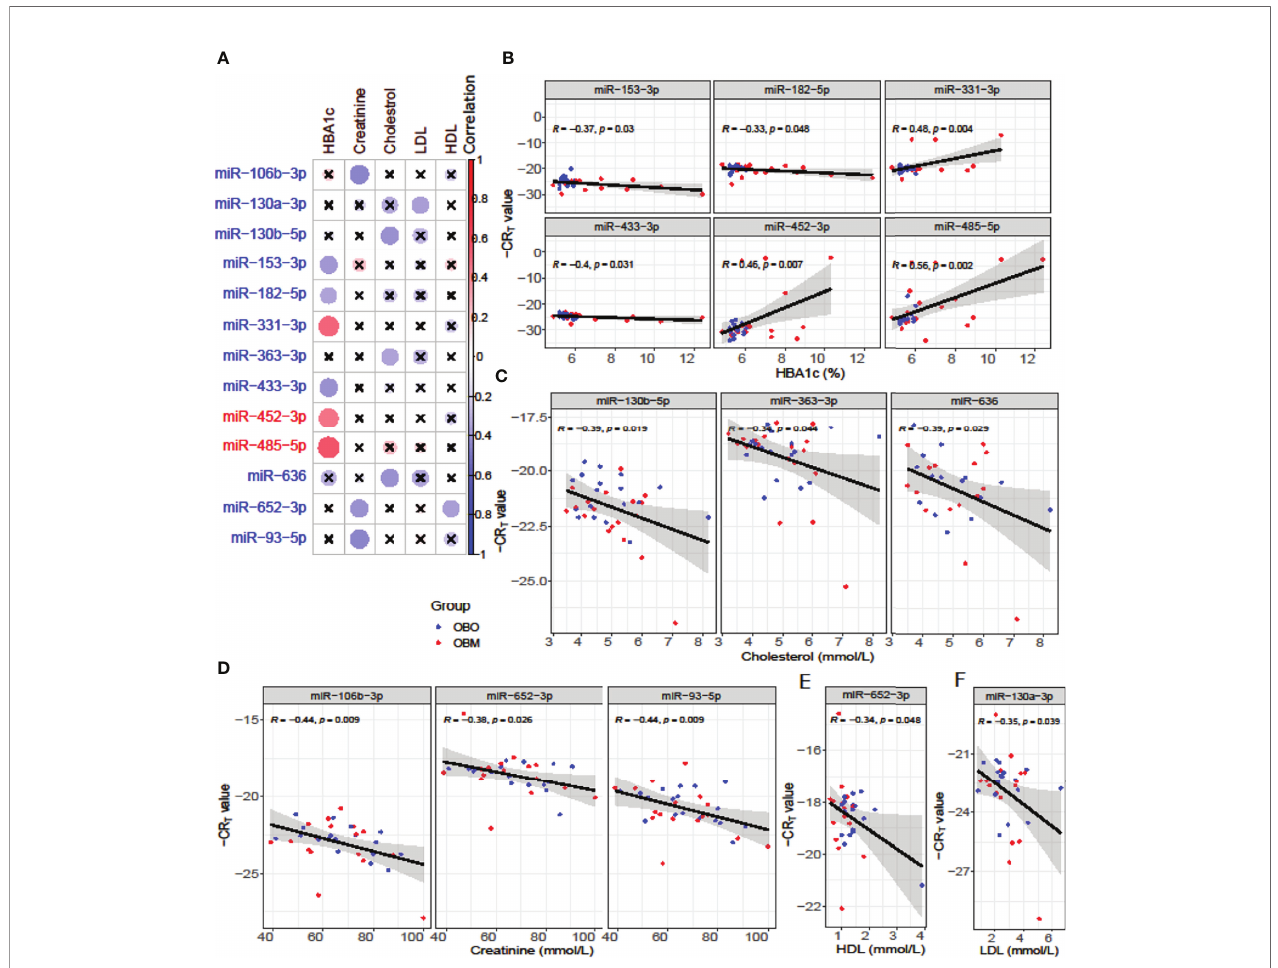
FIGURE 3 | (A) Pearson correlation between clinical traits relevant to metabolic syndrome and miRNA expression (-CR T values). The ‘ x ’ represents that the correlation coef fi cient is not signi fi cant. The darker the correlation coef fi cient ( ‘ red ’ or ‘ blue ’ ) the stronger the correlation (more towards +1 or more towards -1). Signi fi cant correlations (p< 0.05) of clinical traits with relevance to metabolic syndrome with the differentially expressed miRNAs. (B) Correlation with HBA1c; (C) Correlation with Cholesterol; (D) Correlation with Creatinine; (E) Correlation with HDL, and (F) Correlation with